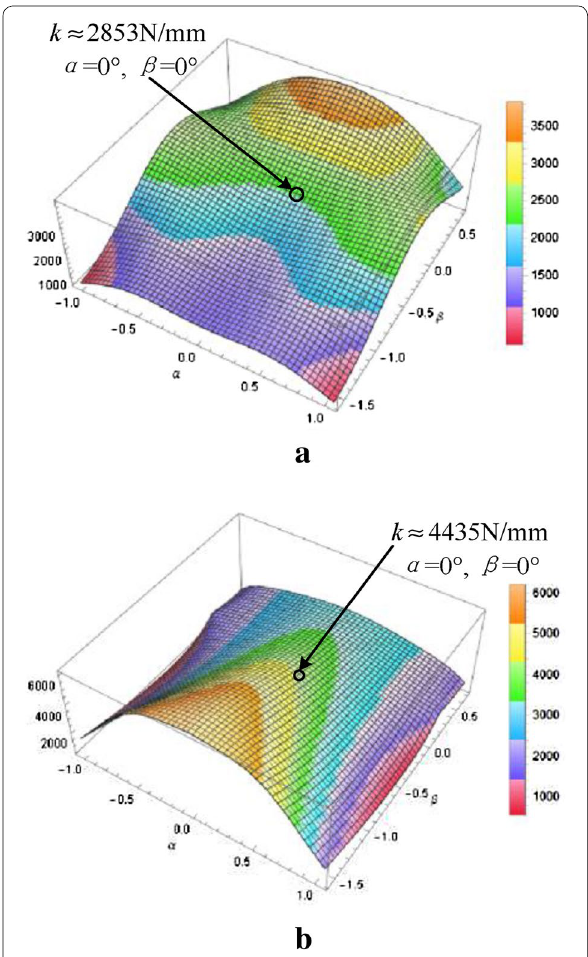
Figure 9 Stiffness distribution of the mechanism in the single support phase: a 2-UPR parallel mechanism; b 2-UPR/ URR parallel mechanism Figure 10 Deformation under external load